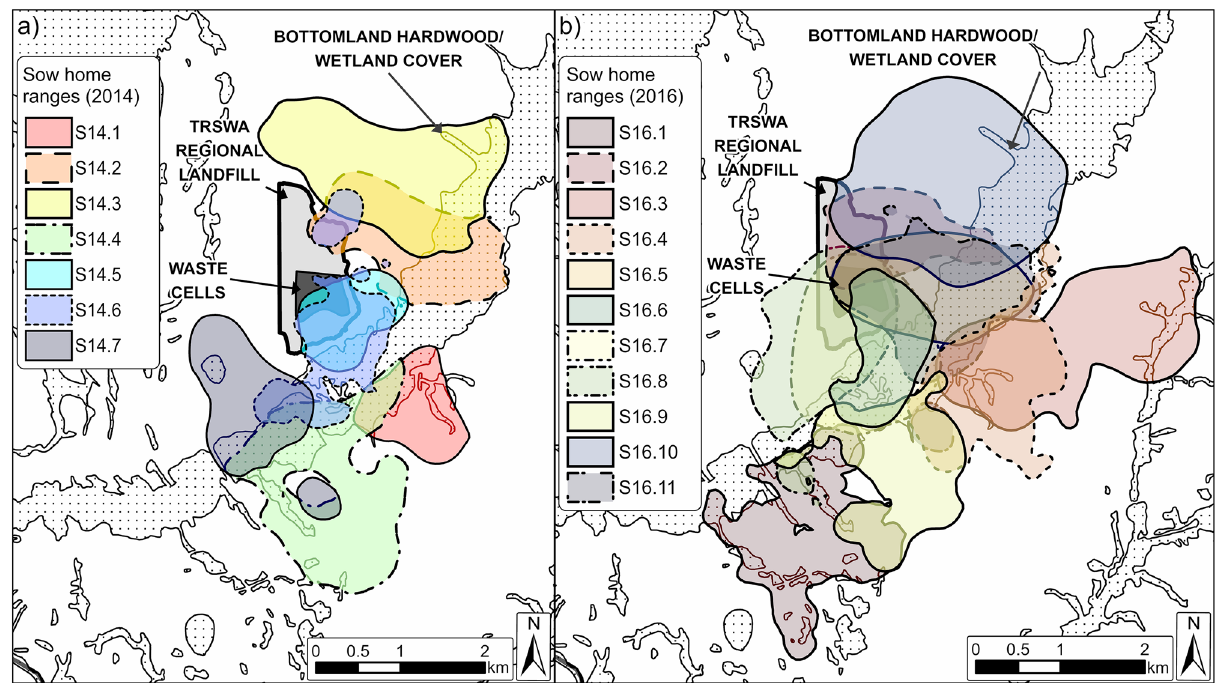
Figure 2. Season-long (3.5 months; 27 Mar–12 Jul) home ranges (95% utilization distribution contours) of wild pigs ( Sus scrofa ) tracked on Savannah River Site, South Carolina, USA, in 2014 ( a ; n pigs = 7) and 2016 ( b ; n pigs = 11). Map created using ArcGIS Pro version 2.8.1 (https:// www. esri. com) 17